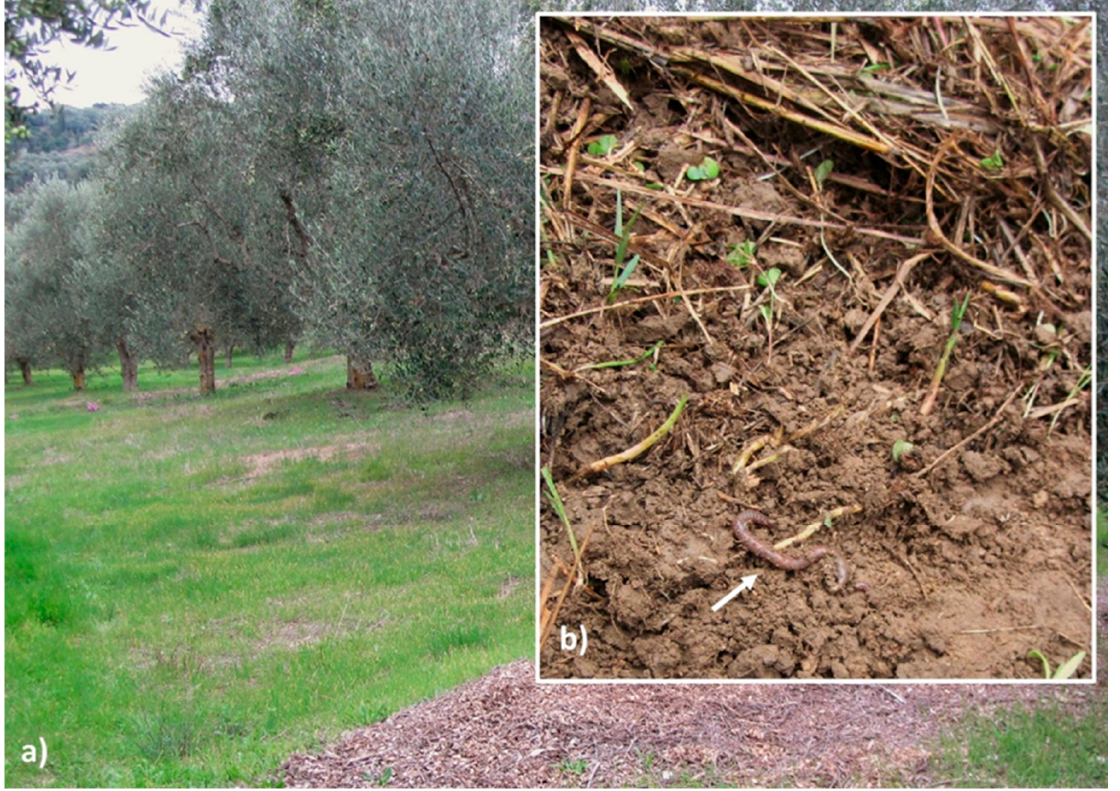
Figure 6. ( a ) Olive orchard with permanent grass cover, straw and pruning mulching. ( b ) Close-up of the topsoil under the mulch. Earthworms activity and good soil structuration are evident.